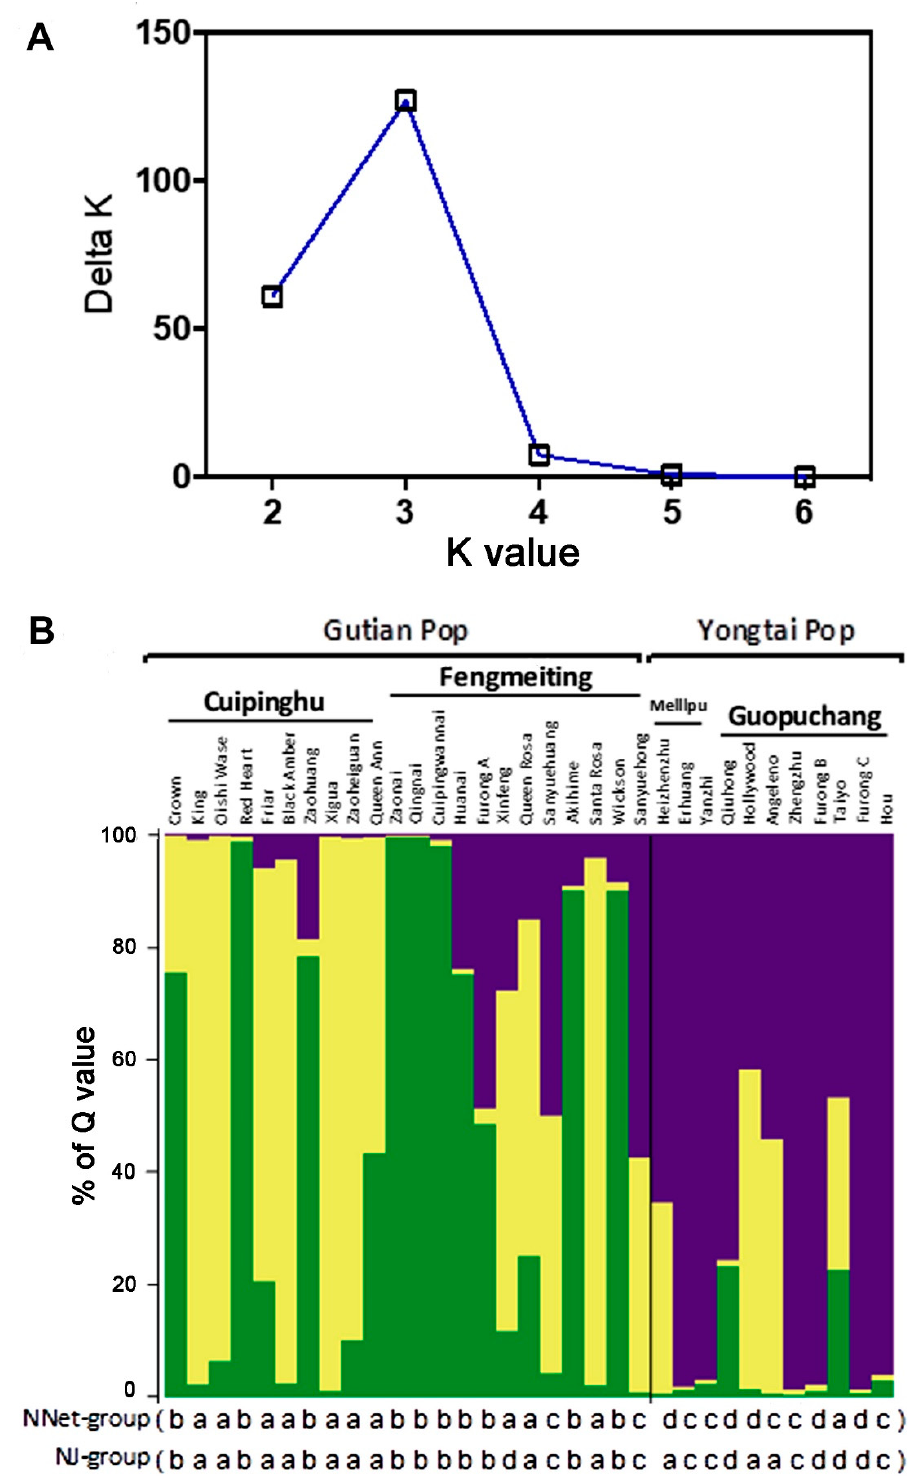
Figure 3. The Bayesian analysis of genetic structure of 33 varieties. ( A ) Plot from Structure Harvester showed K = 3 inferred by the estimation of the △ K parameter. ( B ) Bar plot of the results from the Bayesian analysis ( K = 3) of 33 varieties. Each variety is represented by a vertical bar, which is partitioned into colored segments whose length depends on the estimated membership fraction (Q) in each population. Varieties are assigned to a specific population when the highest Q is higher than 0.6. Three populations are colored in yellow as the Cuipinghu population, green as the Fengmeiting population, and purple as the Guopuchang and Meilipu population. Varieties classified into a, b, c, and d groups by NNet and NJ methods (Figure 2) are listed under the bar plot.